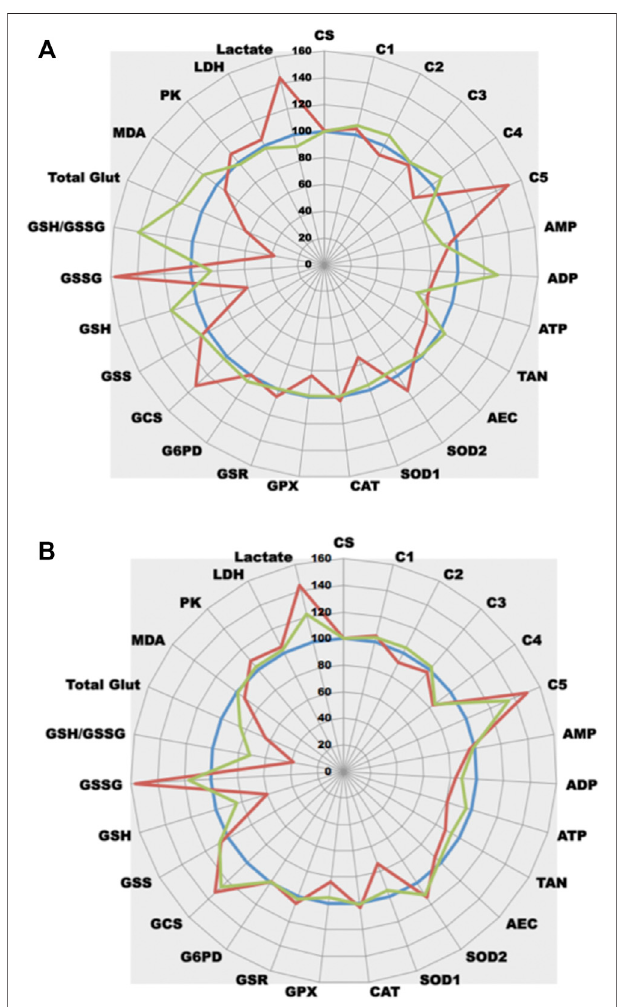
FIGURE 5 | Comparative analysis of the effect of glucose on cell metabolism. (A) Three different glucose concentrations were tested at t12h (1 g/Lblueline,normalcontrolas100%;2.5g/Lgreenline;5g/Lredline)inacell line model (prostate PNT1A cells). Each point represents the mean of 5 independent experiments. (B) A unique dose of 5 g/L glucose was tested at 3 different times t10m (blue line, normal control as 100% obtained with 10 min contact of cells with 5 g/L medium), t6h (green line) and t12h (red line) in a cell line model (prostate PNT1A cells). Each point represents the mean of 5 independent